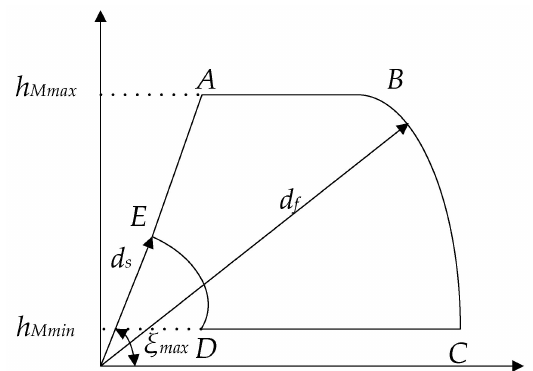
Figure 7. Horizontal section of surface-to-air missile threat range.